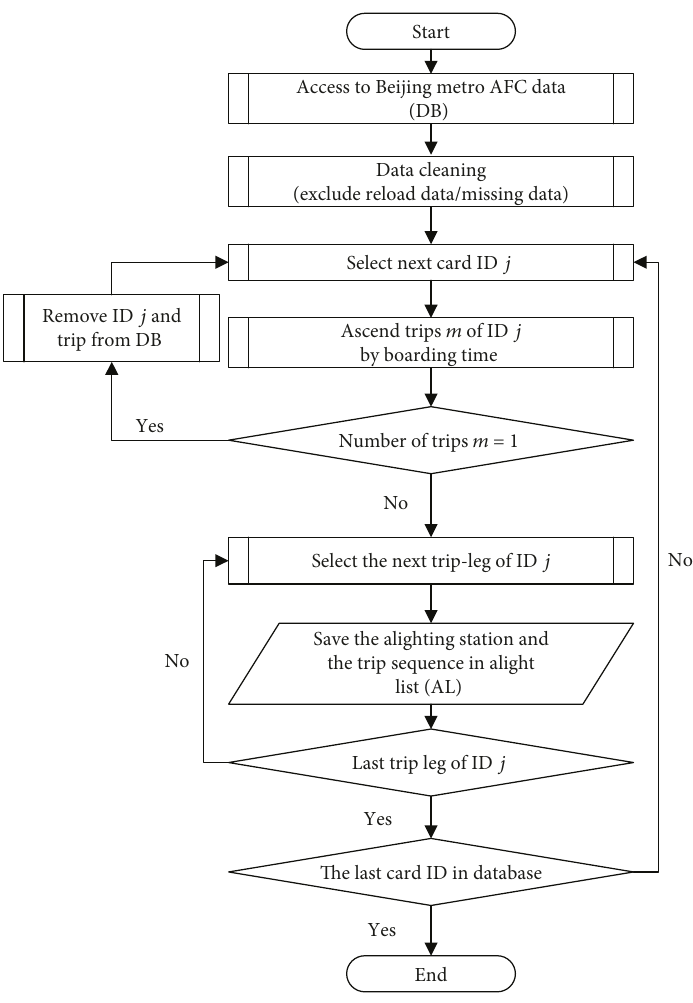
Figure 1: Data preparation